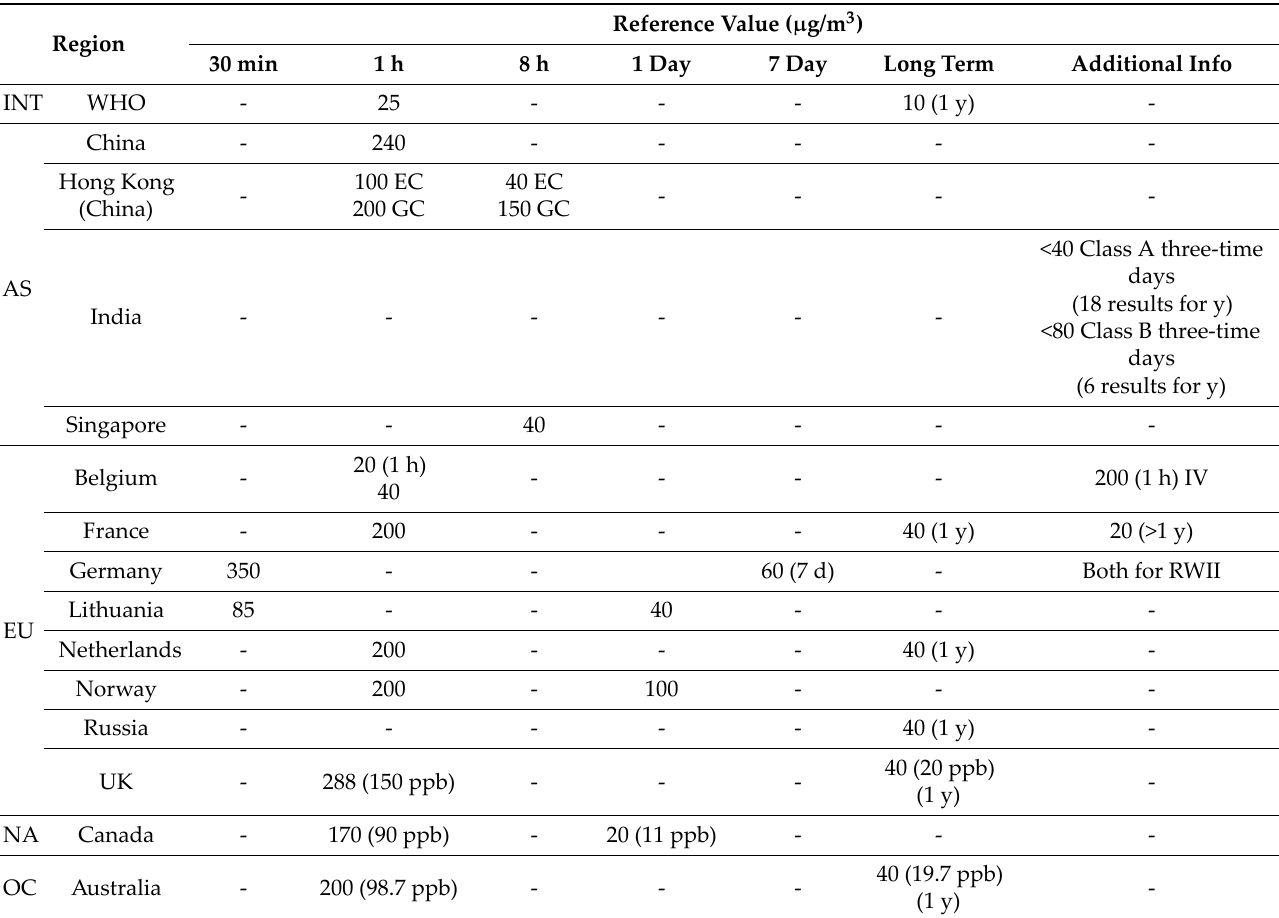
Table 11. Reference values for nitrogen